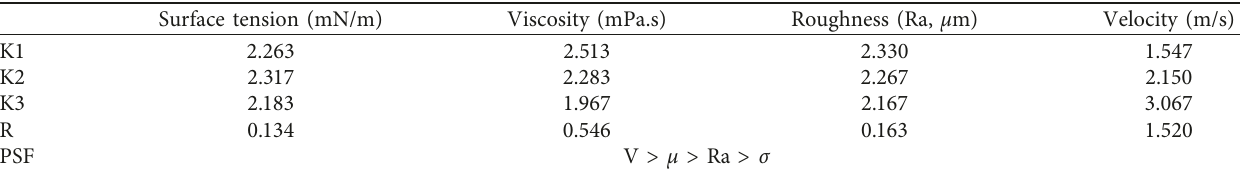
Table 3: Range analysis results.